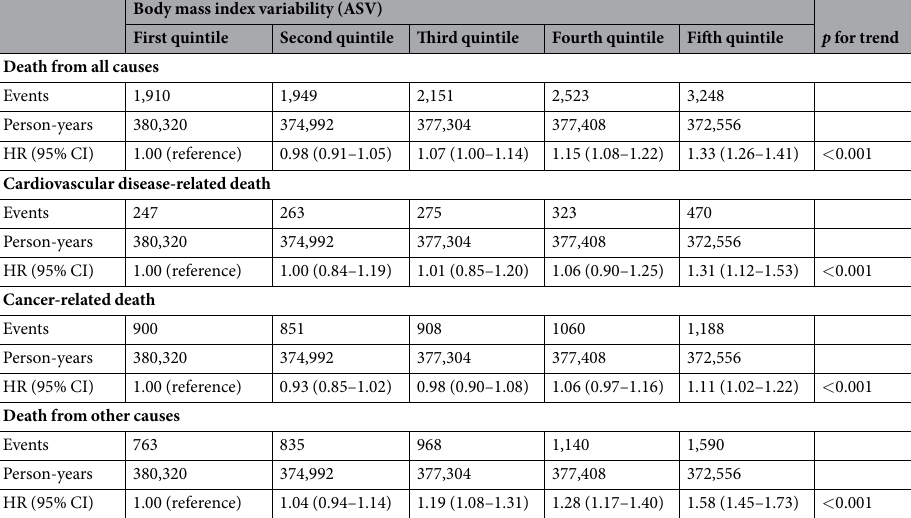
Table 2. Effect of weight variability on death from all causes, cardiovascular disease, cancer, and other causes. Hazard ratio calculated by Cox proportional hazards regression analysis after adjustments for age, sex, baseline body mass index, change in body mass index, household income, smoking, alcohol consumption, physical activity, systolic blood pressure, fasting serum glucose, total cholesterol, underlying cancer, and underlying cardiovascular disease. Acronyms: ASV, average successive variability; HR, hazard ratio; CI, confidence